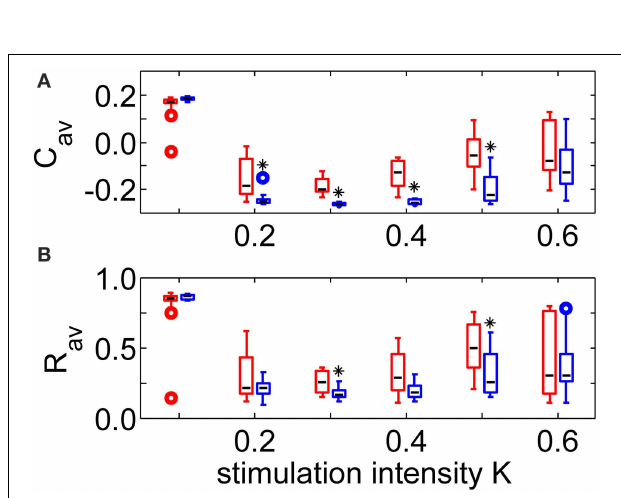
FIGURE 3 | Effect of the sequence order and of the initial network conditions on the average synaptic weight C av at t = 128 s as a function of stimulation intensity K . (A) C av -values at t = 128 s obtained by the RVS CR stimulation. (B) C av -values at t = 128 s obtained by the SVS-100 CR stimulation. The C av ( t = 128 s) values in Figure 2 are the reference results and represented by the solid lines in